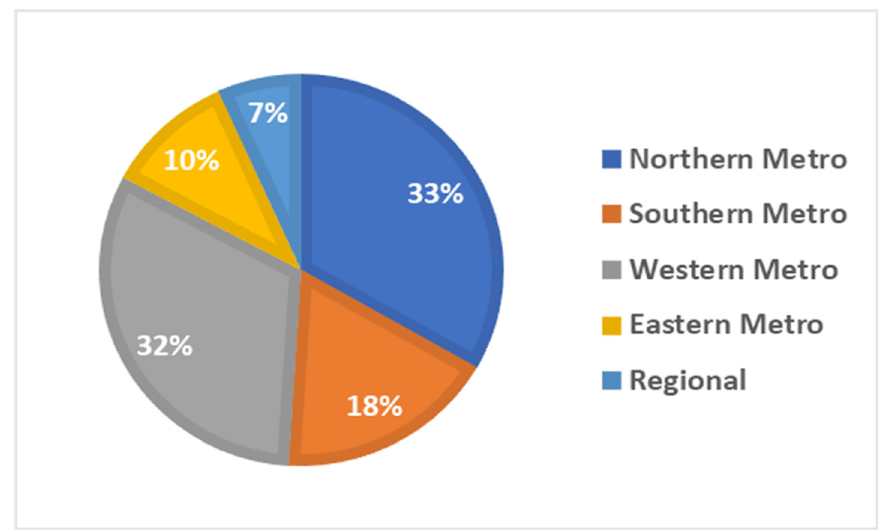
Figure 3. The percentage of Teledentistry appointments by Victorian region ( n = 2492).